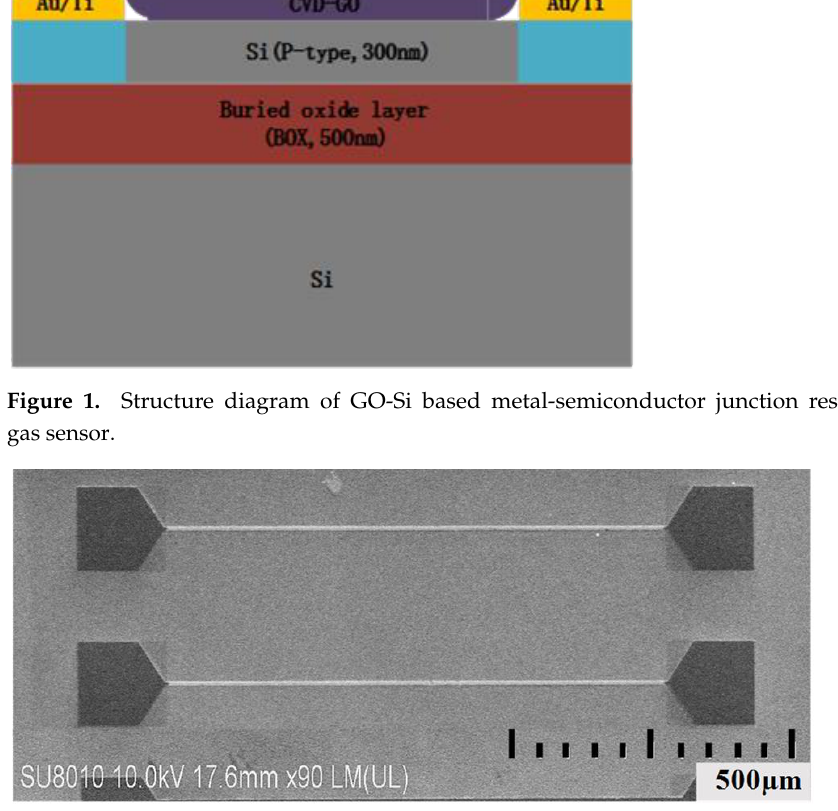
Figure 2. The SEM Figure 2. The SEM images.